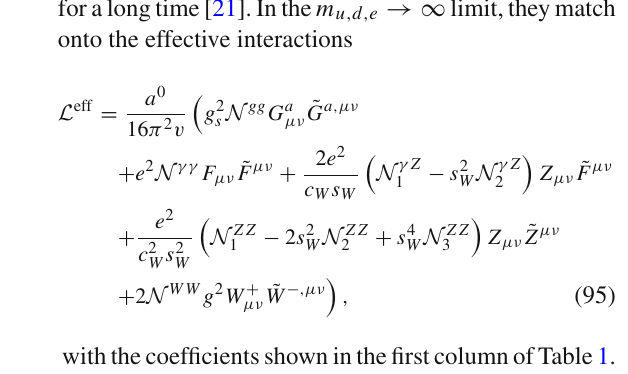
Table 1 in the m u , d , e → ∞ limit for a 0 → γγ, gg . Indeed, in the polar representation, these amplitudes receive two contributions, M ano from the local anomalous term, and M der from the triangle amplitudes built from ∂ μ a 0 ¯ ψγ μ γ 5 ψ . But in this case, the axial Ward identity translates as M der = M lin − M ano , with M lin the THDM amplitude. So, even if parametrically, M lin = M ano and M der = 0 when m u , d , e → ∞ , a 0 → γγ, gg are not induced by the anomaly since it cancels out in + M M ano der